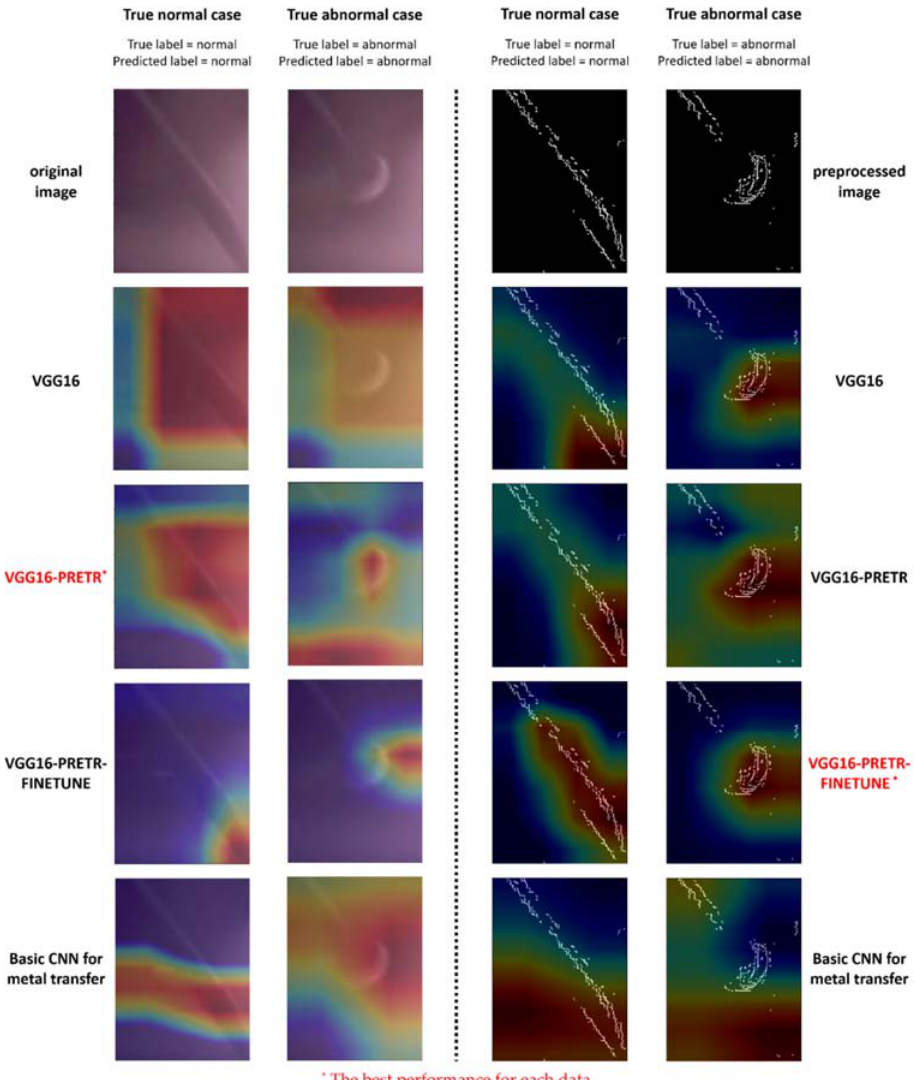
Figure 10. Visual verification using Grad-CAM for original and preprocessed images. As shown in Figure 10, the image is separated into two sections. The original image and trained features from the original image are located on the left section, and the pre- processed image and their trained features on the right section. In each section, the left image represents the true normal case when the CNN model classifies normal data as normal. The right image shows a true abnormal case in which the CNN model classifies abnormal data as abnormal. The image on the top represents the trained data (original and preprocessed images), whereas the images below the first row in Figure 10 show the Grad-CAM images for each CNN model, such as VGG16, VGG16-PRETR, VGG16- PRETR-FINETUNE, and basic CNN for metal transfer. The bright red color in the Grad-